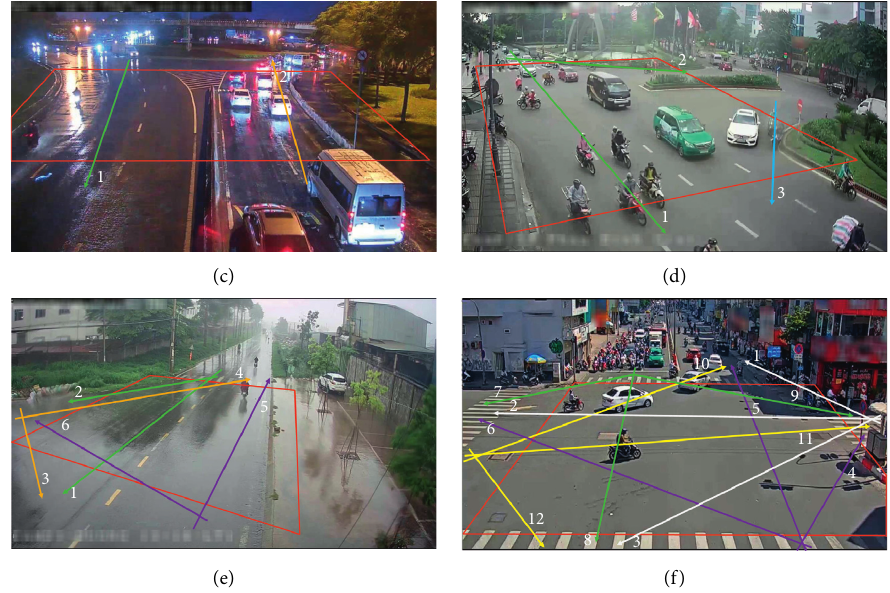
Figure 9: Different scenarios captured from VDD with predefined ROO and DOM. (a) VDD Scene-1, (b) VDD Scene-2, (c) VDD Scene-3, (d) VDD Scene-4, (e) VDD Scene-5, and (f) VDD